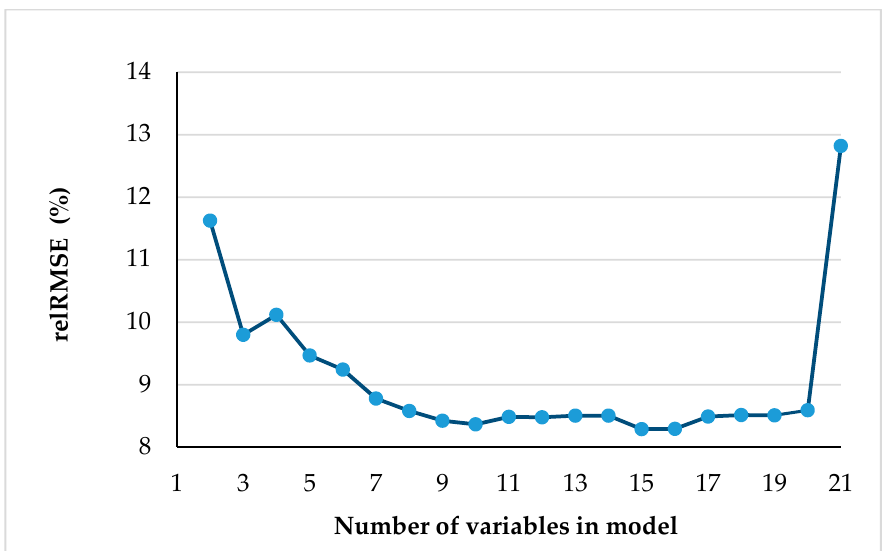
Figure 4. Relative RMSEs obtained by backward elimination of variables from the random forest model.